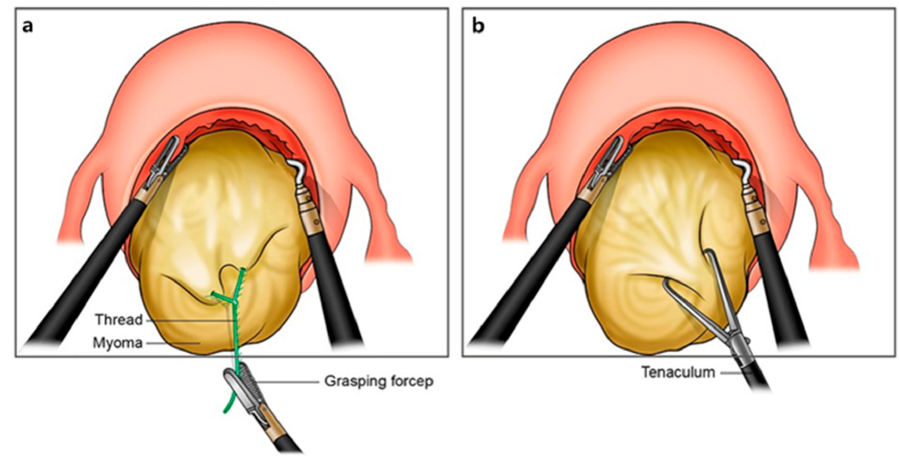
Figure 3. Comparison of the two traction methods: ( a ) locking suture on myoma (LSOM) technique and ( b ) conventional method using Tenaculum forceps.